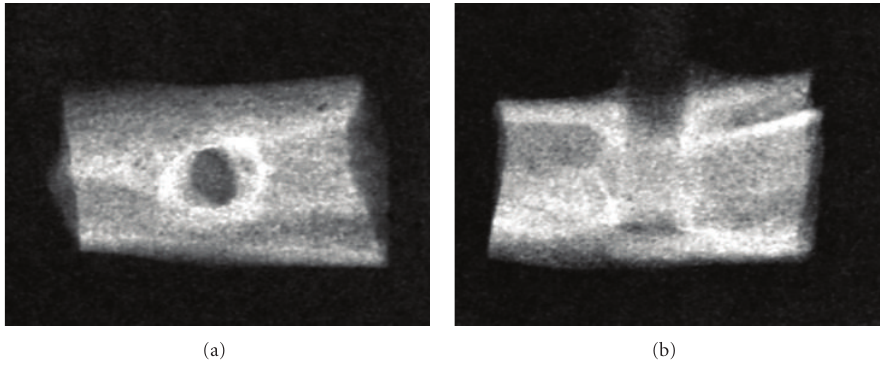
Figure 3: X-ray Imaging: (a) Frontal view. (b) Lateral view.